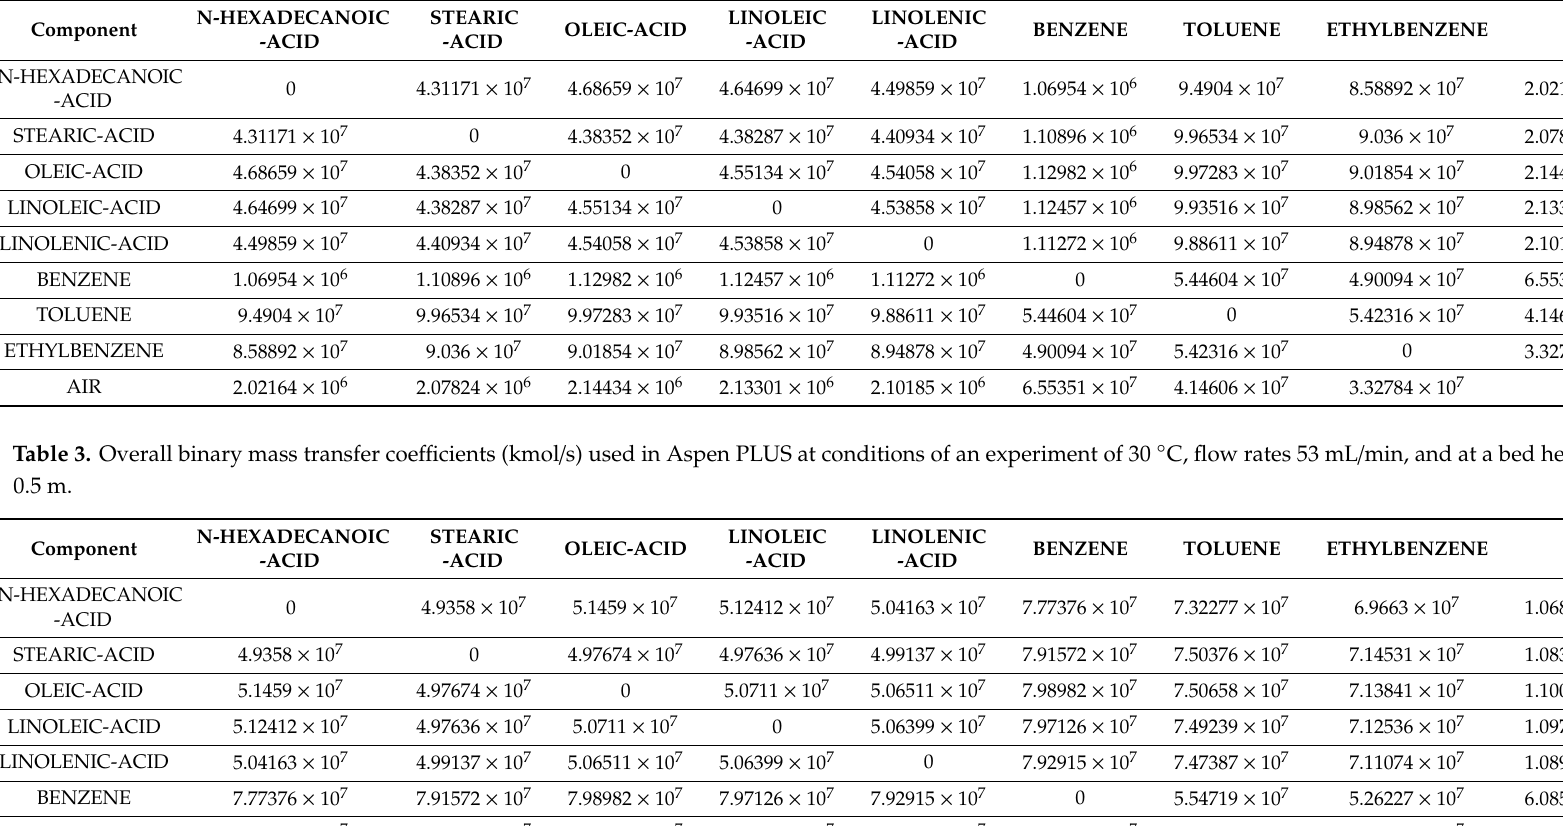
Table 2. Binary di ff usion coe ffi cients (cm 2 / s) used in Aspen PLUS at conditions of an experiment of 30 ◦ C, flow rates 53 mL / min, and at a bed height of 0.5 m.